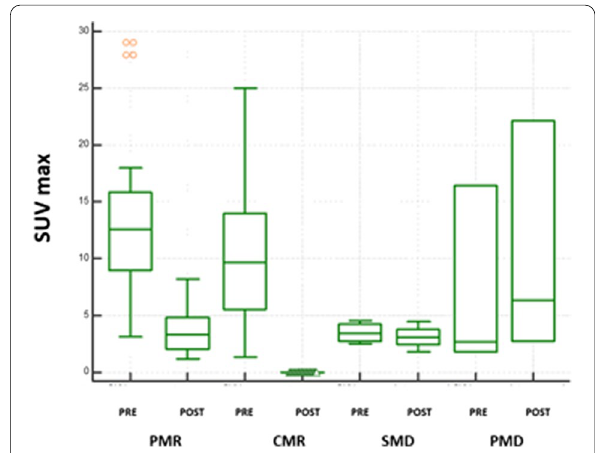
Fig. 5 Box-and-whisker plots of pre-treatment and post-treatment SUV in PMR, CMR, SMD, and PMD groups